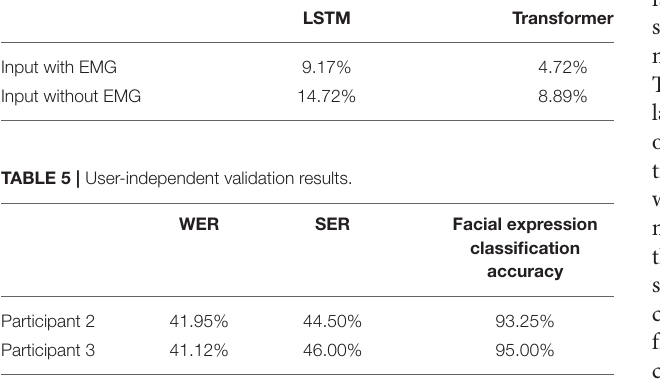
TABLE 4 | Sentence error rate comparison.